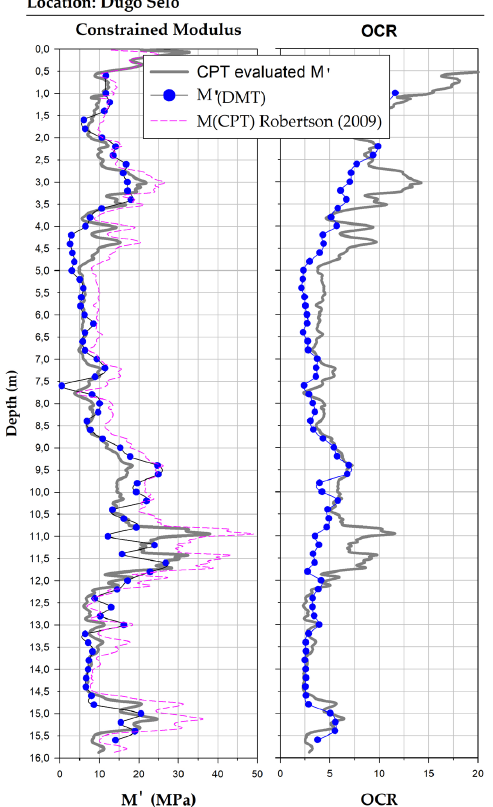
Figure 16. Comparison of CPT evaluated M′ through correlations and constrained modulus M ′ DMT from dilatometer data: ( a ) for silty mixtures; ( b ) for sandy mixtures.